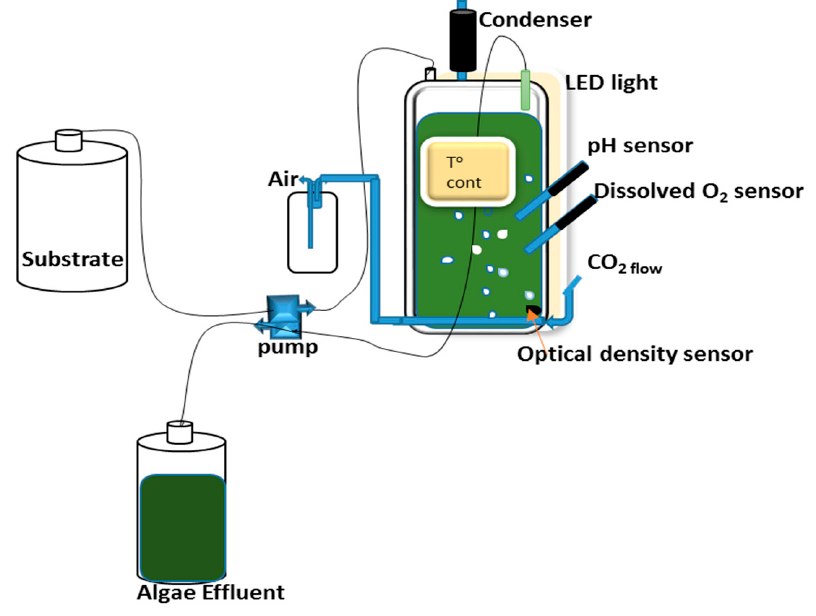
Figure 1. Schematic experimental set-up of the chemostat.